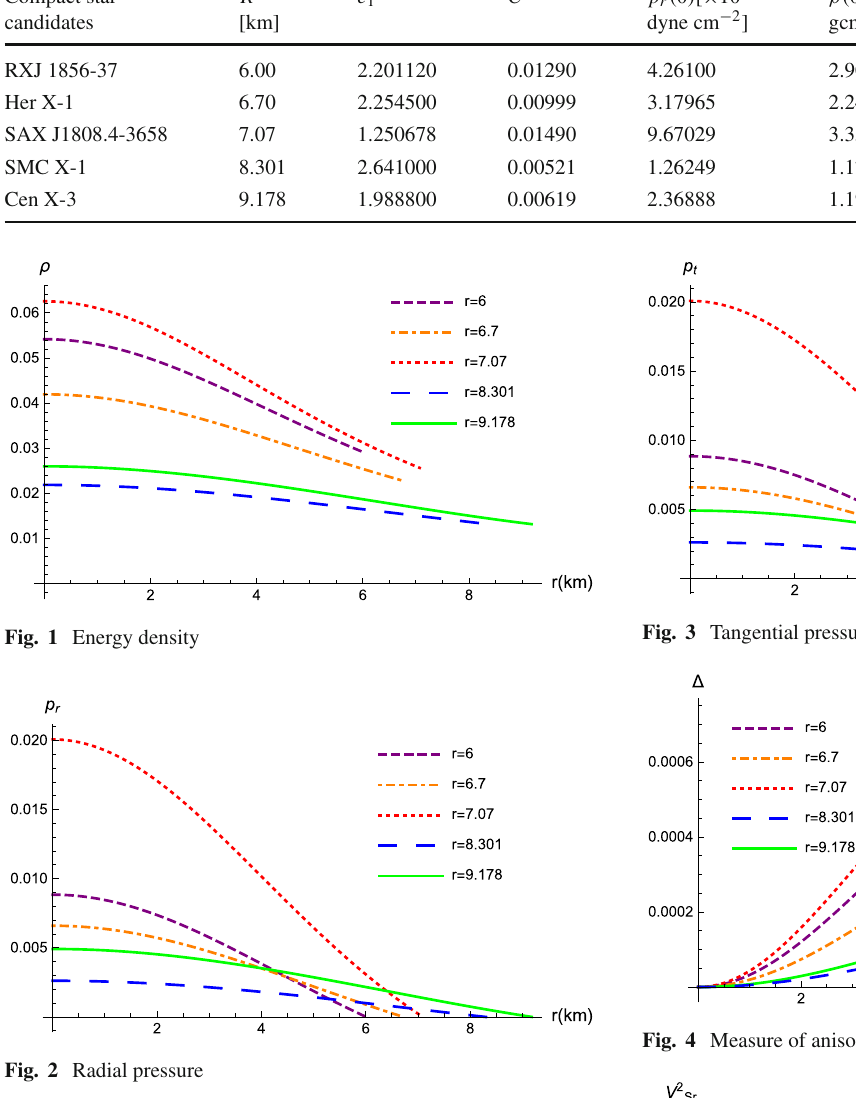
Fig. 2 Radial pressure